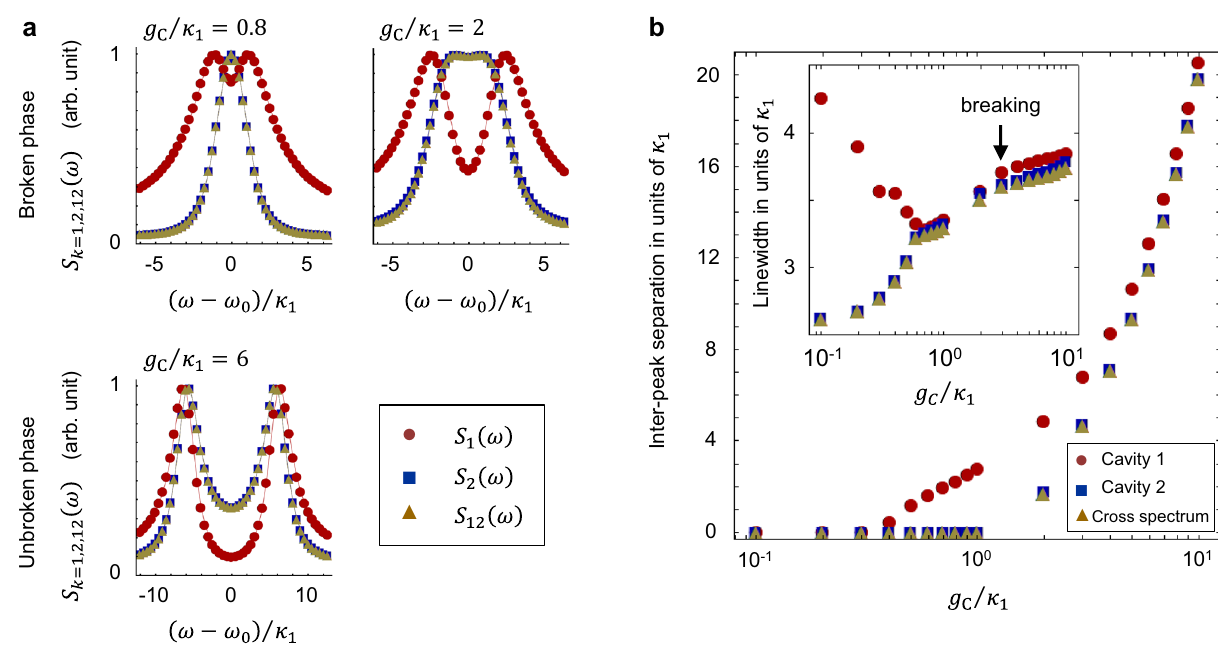
Fig. 6 Emission spectra of two cavity fi elds. a Spectra S k ¼ 1 ; 2 ω ð Þ and cross-spectrum S 12 ω ð Þ at several different intercavity coupling strengths g C . Here, k ¼ 1 ; 2, respectively, represent the cavities 1 and 2, ω denotes the angular frequency in the frequency domain, and ω 0 corresponds to the central frequency of the laser transition. The loss rate κ 1 of cavity 1 is chosen as the frequency unit in the plot. b Interpeak separations of S k ¼ 1 ; 2 ω ð Þ and S 12 ω ð Þ as a function of g C . Inset: Linewidths of the spectral peaks in S k ¼ 1 ; 2 ω ð Þ and S 12 ω ð Þ vs. g C . The peak linewidths are evaluated by means of curve fi tting (see “ Methods ” ). The arrow shows the phase transition boundary, above which the interpeak separations exceed the linewidths of spectral peaks in both spectra S k ¼ 1 ; 2 ω ð Þ